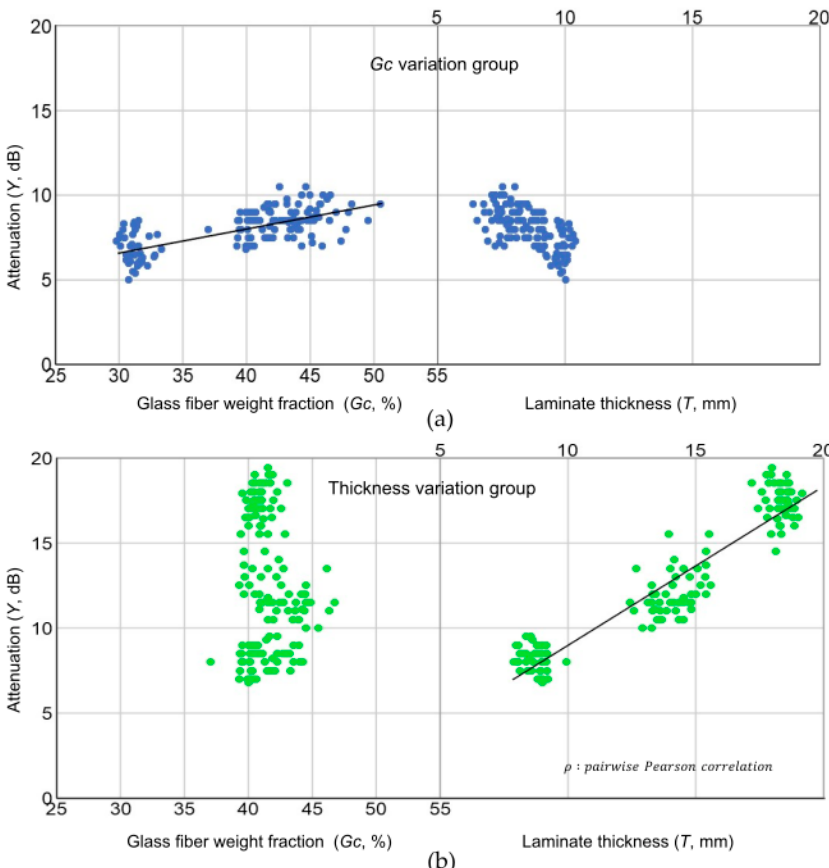
Figure 11. Pearson’s correlation analysis to investigate the effect of the Gc and laminate thickness on attenuation. ( a ) Gc variation group. ( b ) Thickness variation group.